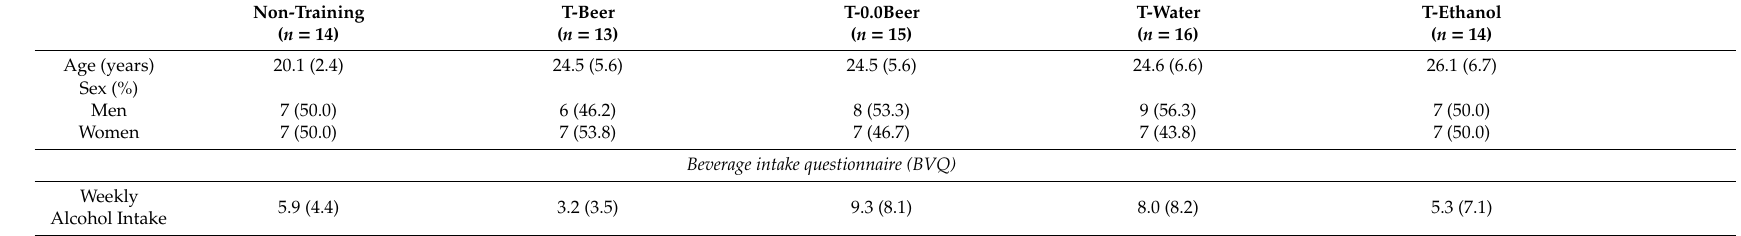
Table 1. Descriptive parameters and anthropometric and body composition variables before and after the intervention